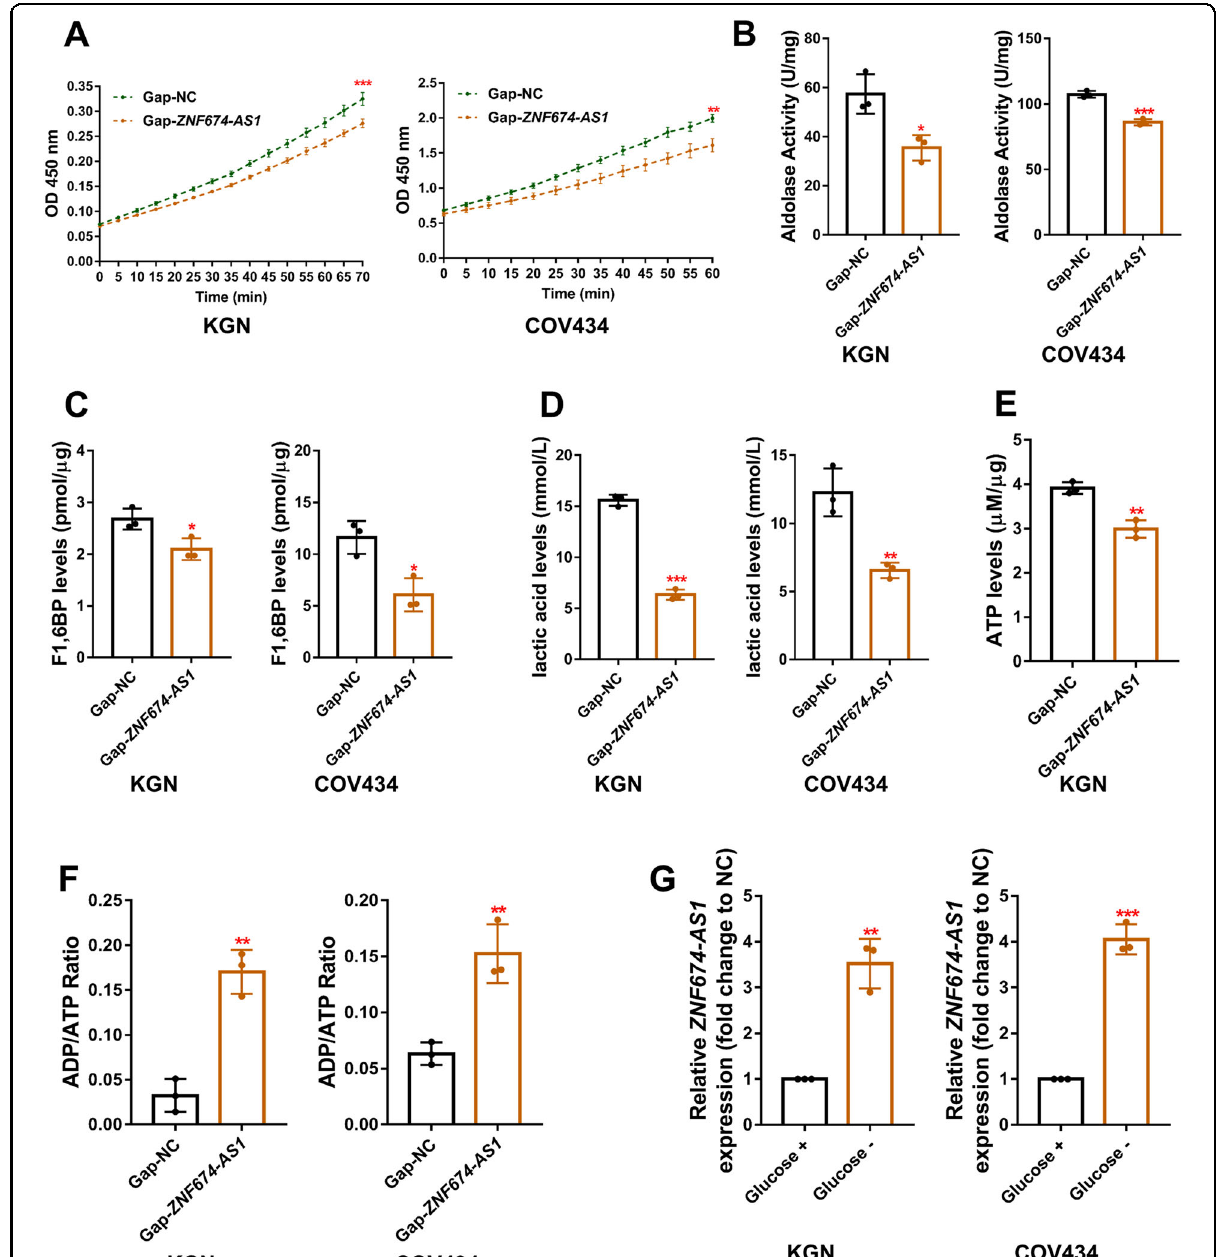
Fig. 4 LncRNA ZNF674-AS1 is involved in the glycolysis and glucose metabolism of GCs. A , B The aldolase activities of KGN and COV434 cells after ZNF674-AS knockdown were examined by an Aldolase Activity Colorimetric Assay Kit and compared with control cells. Results are normalized to the total protein and expressed as the mean ± SD ( n = 3), * p < 0.05, ** p < 0.01, *** p < 0.001 by two-sided Student ’ s t test. C Levels of F1,6BP in KGN and COV434 cells after ZNF674-AS1 silencing were measured and normalized to the total protein. Results are expressed as the mean ± SD ( n = 3), * p < 0.05, by the two-sided Student ’ s t test. D Lactic acid production in ZNF674-AS1 silenced and negative control KGN and COV434 cells was measured via Lactate Colorimetric Assay Kit. Results are expressed as the mean ± SD ( n = 3), ** p < 0.01, *** p < 0.001 by two-sided Student ’ s t test. E Levels of ATP in ZNF674-AS1 silenced and negative control KGN cells were measured and normalized to the total protein. Results are expressed as the mean ± SD ( n = 3), ** p < 0.01 by two-tailed Student ’ s t test. F The ratio of ADP/ATP in ZNF674-AS1 silenced and negative control KGN and COV434 cells were detected. Results are expressed as the mean ± SD ( n = 3), ** p < 0.01 by two-tailed Student ’ s t test. G The expression levels of ZNF674-AS1 were analyzed by qRT-PCR in glucose-containing and glucose-free medium cultured KGN and COV434 cells. Results were expressed as the mean ± SD ( n = 3). ** p < 0.01, *** p < 0.001 by two-tailed Student ’ s t